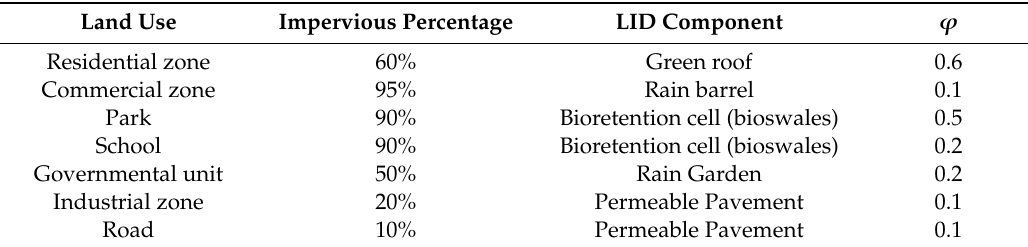
Table 3. The low impact development (LID) setting for di ff erent land use.